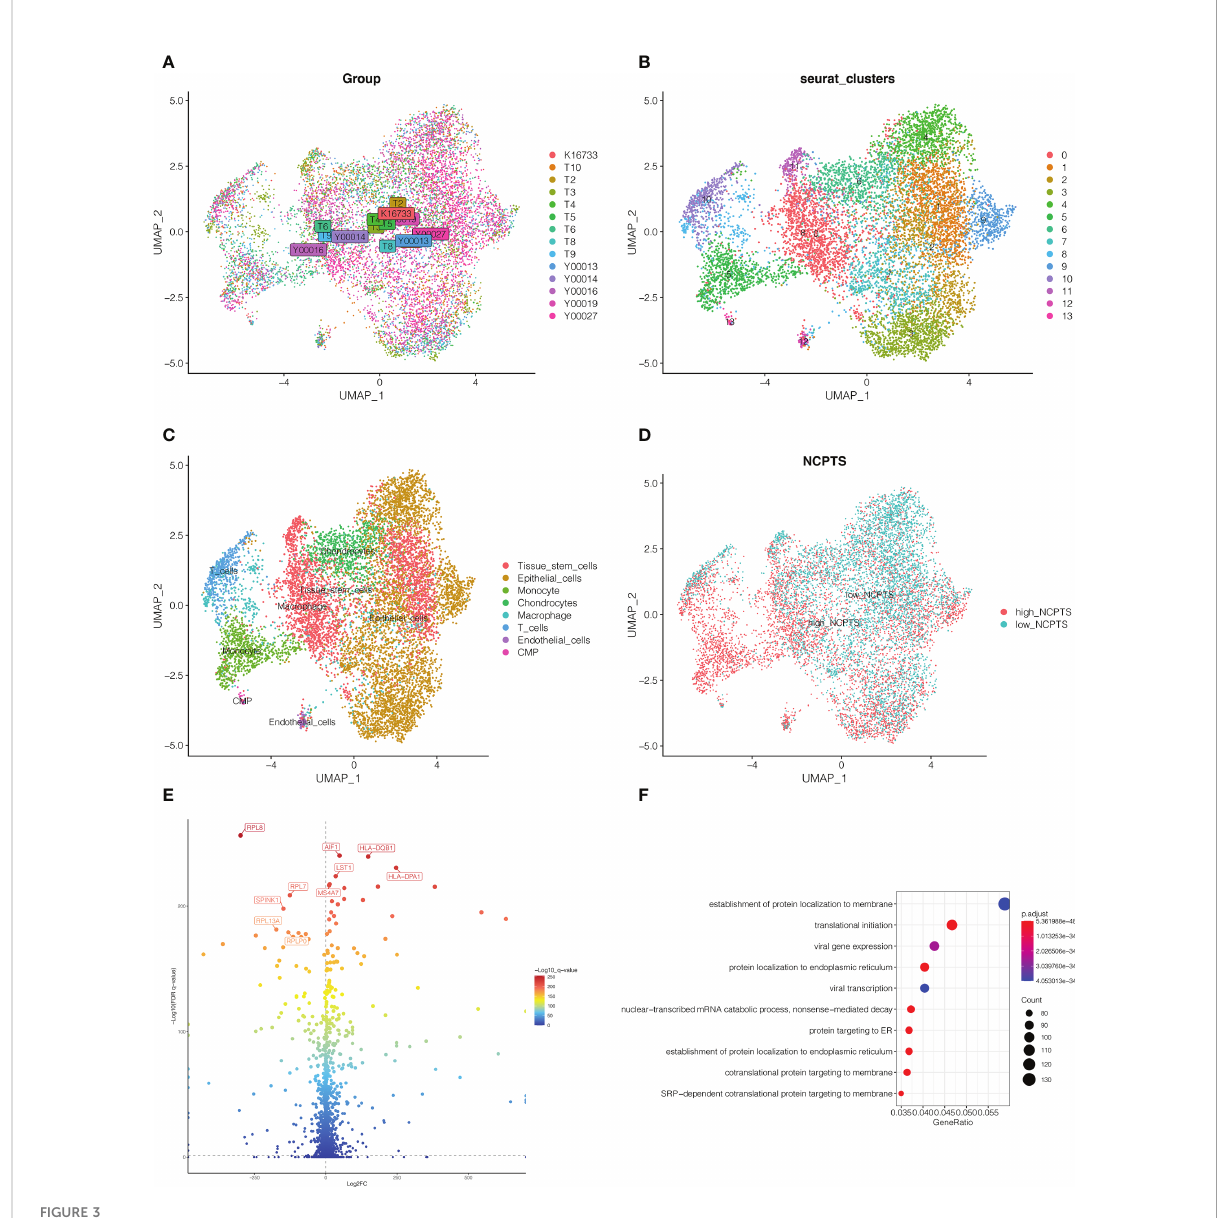
FIGURE 3 Single cell sequencing analysis. (A) A total of 14 samples were included in the study. Cells were evenly distributed among all samples, suggesting no obvious batch effect among all samples. (B) Dimension reduction and cluster analysis. All cells were clustered into 14 clusters. (C) Classi fi cation of cells. A total of 8 cell types can be found, such as epithelial cell, macrophage cell and T cell. (D) The cells were divided into high and low groups, namely high-NCPTs and low-NCPTs. (E) Differential expression gene analysis between high-NCPTs group and low-NCPTs group. A total of 2518 differentially expressed genes between these two groups were obtained(P<0.05). The intersection of these differentially expressed genes with the genes of MEgreenyellow module in WGCNA was obtained to obtain 805 most related genes. (F) Gene ontology(GO) enrichment analysis of differentially expressed